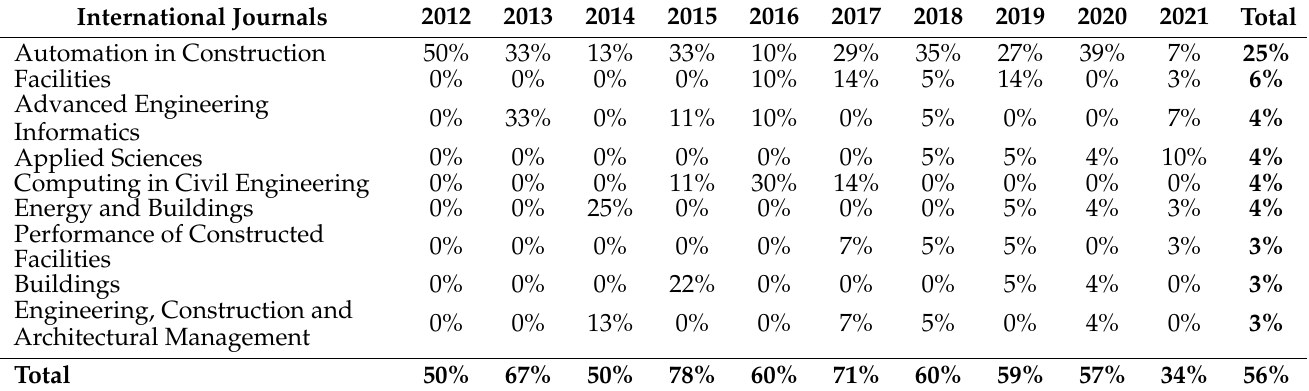
Table 2. Percentage of 10 top published reviewed articles per journal over the last decade.